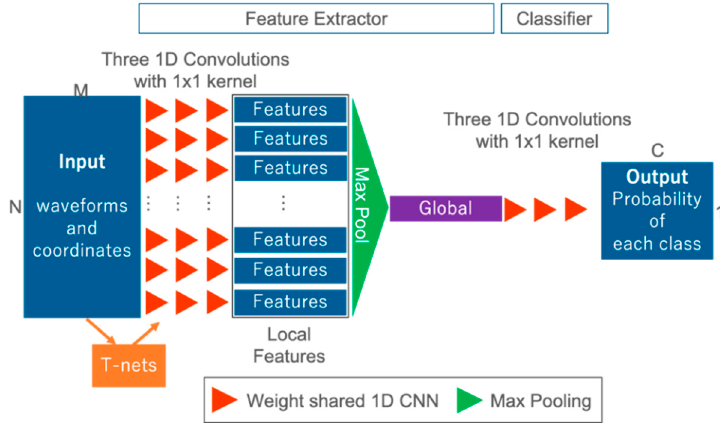
Figure 6. One Output Model architecture. Input: waveforms and coordinates; output: class